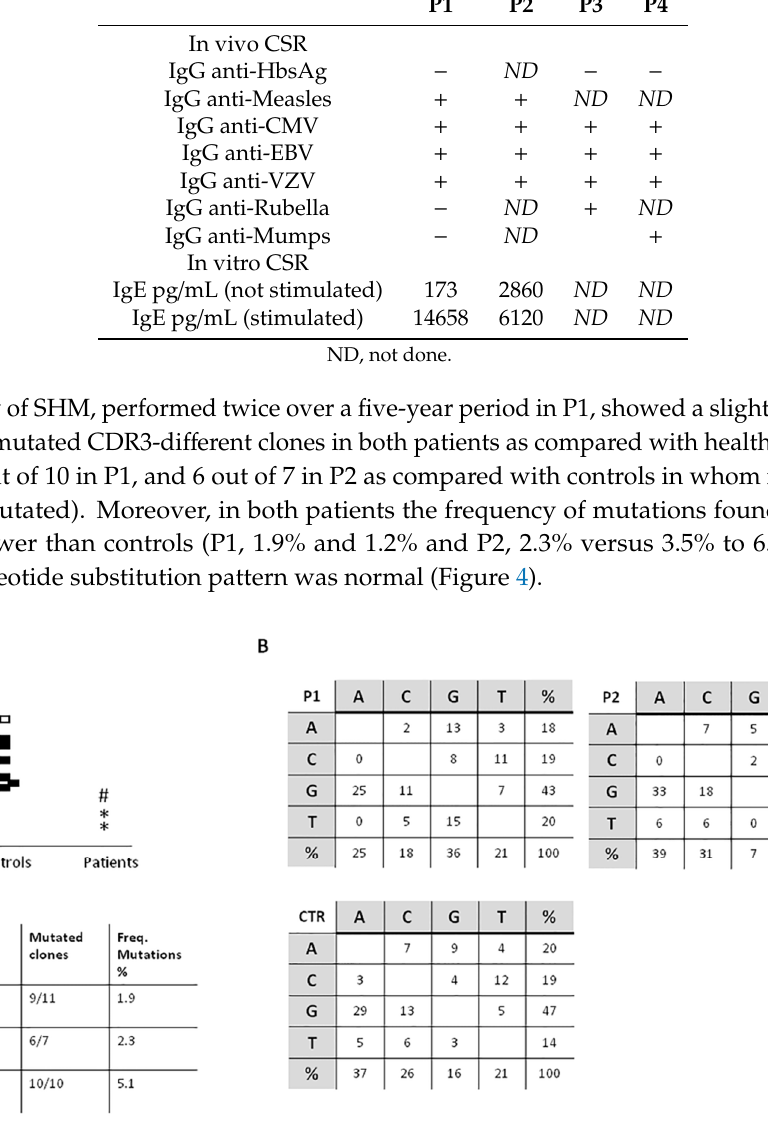
Figure 3. CD40L expression in patient P3 unstimulated and stimulated CD4+ cells as compared with the control.